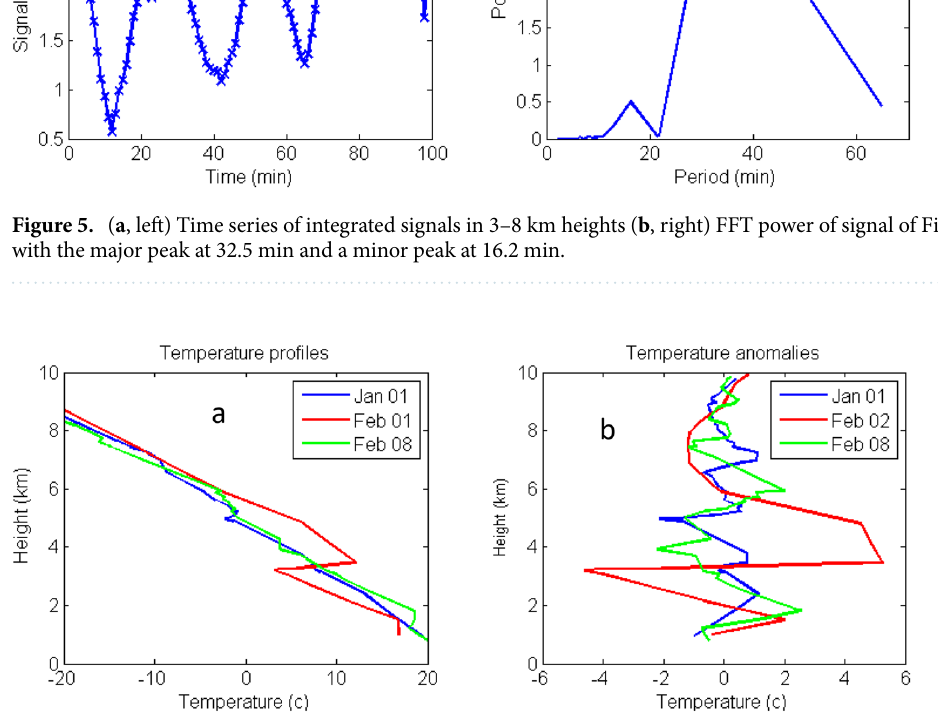
Figure 6. ( a ) Temperature profiles of Taal region on Jan 1, Feb 1, and Feb 8; ( b ) Temperature anomalies.